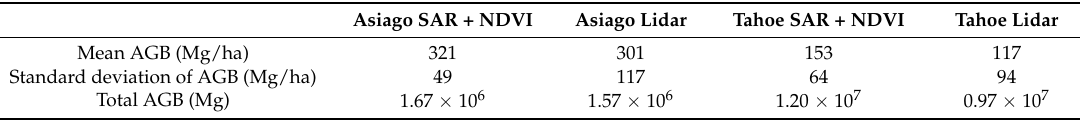
Figure 7. Difference per AGB intervals of the SAR + NDVI map with respect to lidar map. Boxes represent upper (75%) and lower (25%) quartiles; vertical segments out of boxes are minimum and maximum values; boxes are divided by the median. Table 2. Comparison of the lidar-derived and the SAR + NDVI derived AGB maps for the two study